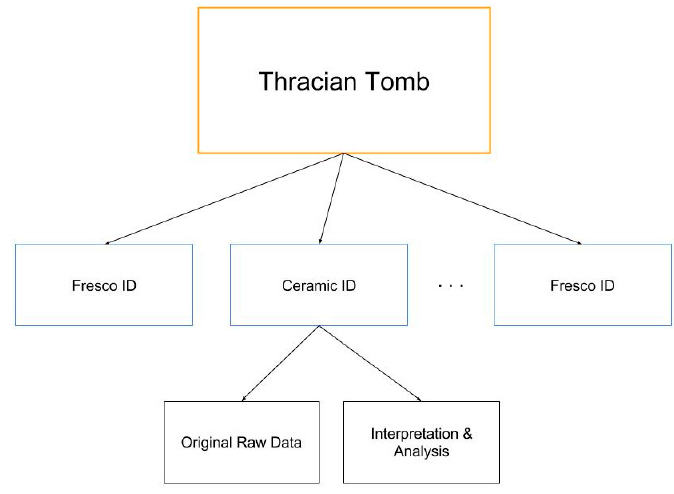
Figure 4. Extensible Markup Language (XML) core tree example.